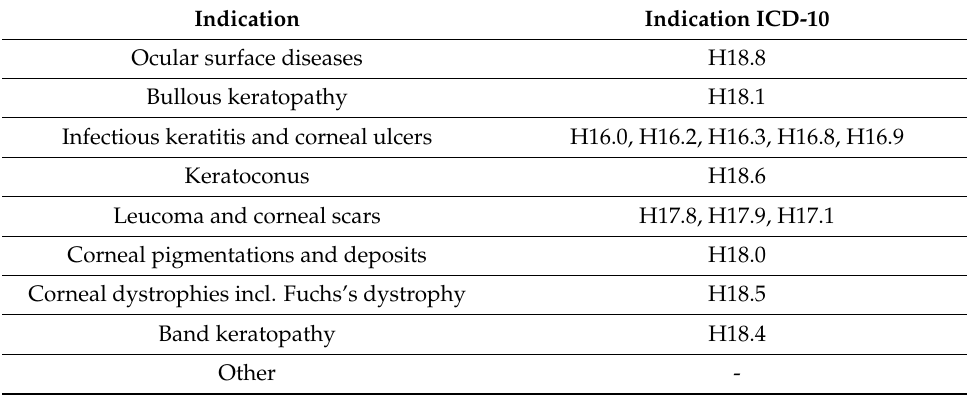
Table A1. Indications for CTs in Poland during 2013–2017.